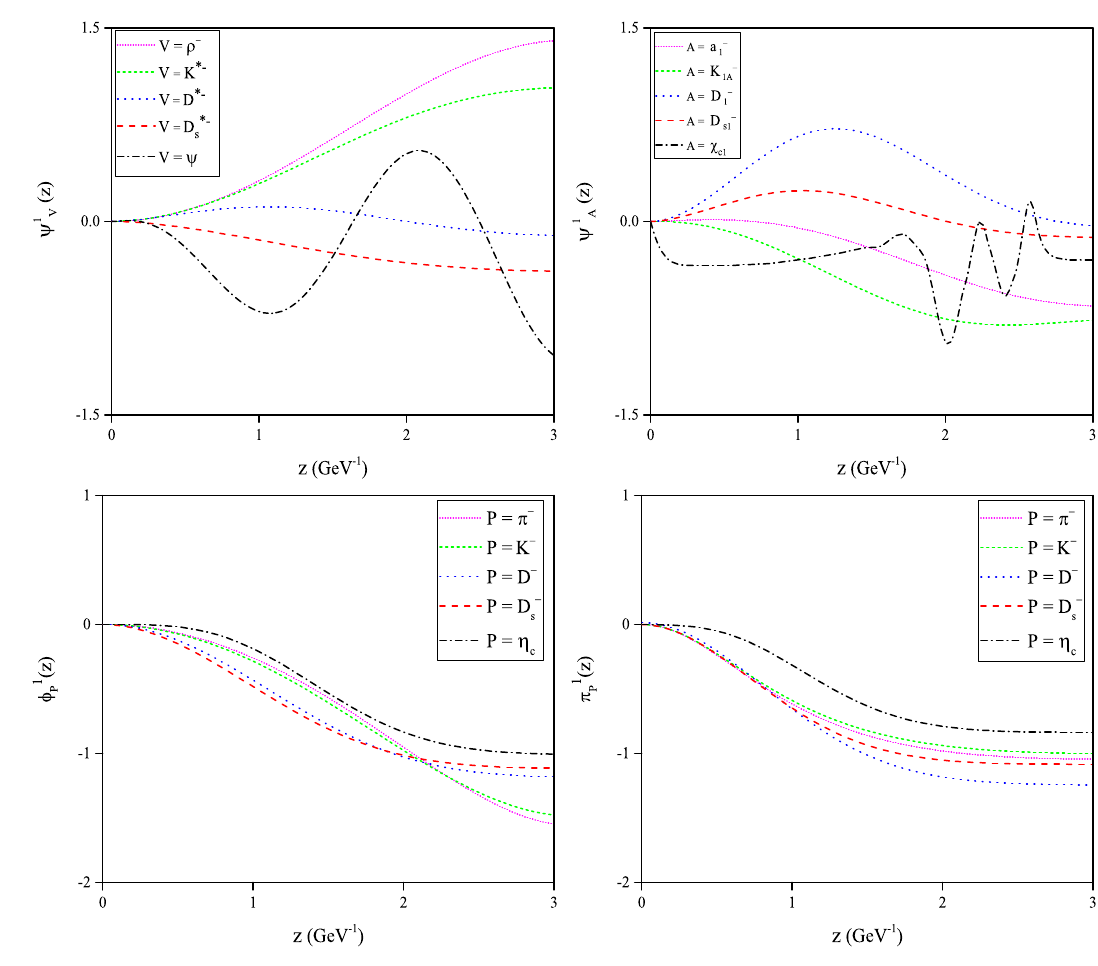
( z ) , ψ 1 ( z ) , φ 1 ( z ) and π 1 ( z ) for V = (ρ − , K ∗− , D ∗− , D ∗− V A P P